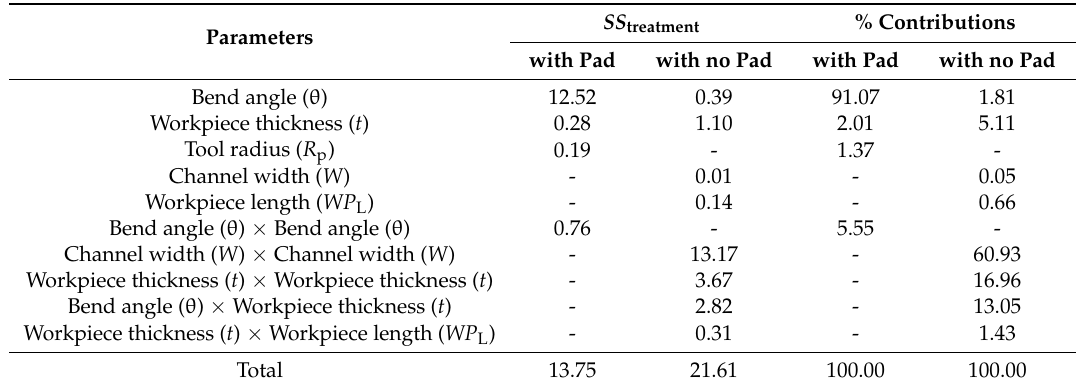
Table 4. Percentage